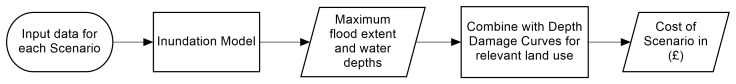
Flow chart showing the process followed to derive the cost of each scenario.